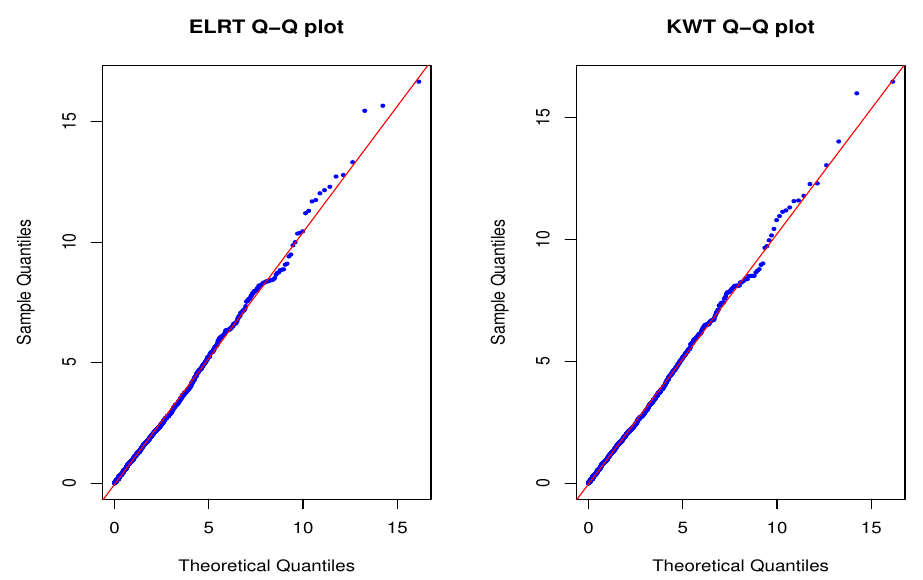
Figure 4. p 0 = 0.25, the sample size is (110,110,120), the Q-Q plots of ELRT and KWT for the overall comparison of the 3 Bernoulli distributions.